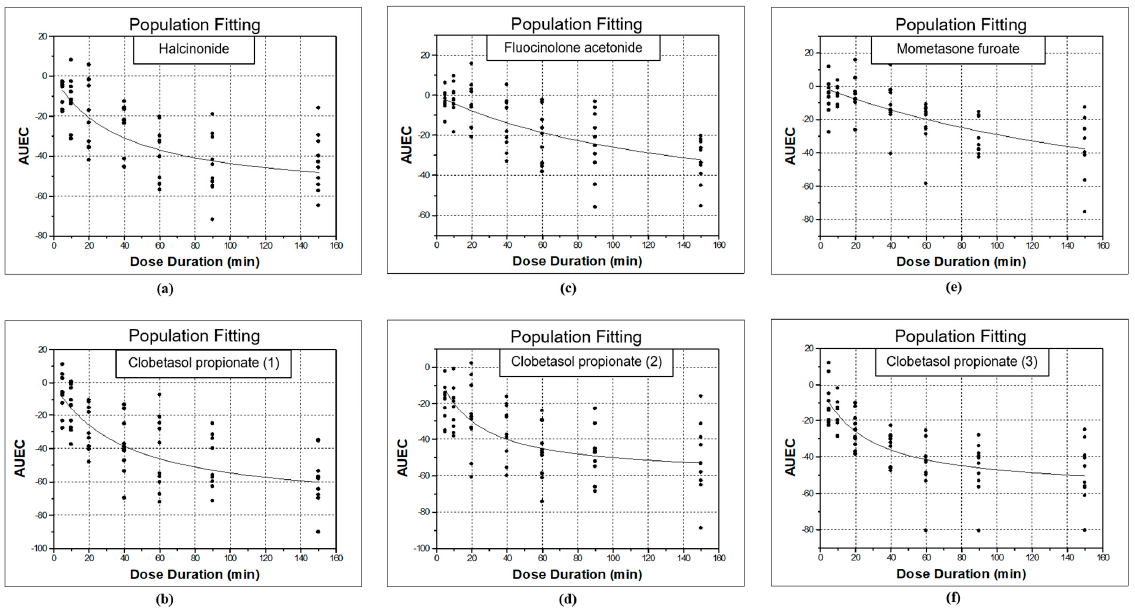
Figure 3. Fitted E max model of AUEC data derived from the chromameter a-scale values for ( a ) halcinonide; ( b ) clobetasol propionate (1); ( c ) fluocinolone acetonide; ( d ) clobetasol propionate (2); ( e ) mometasone furoate; ( f ) clobetasol propionate (3).